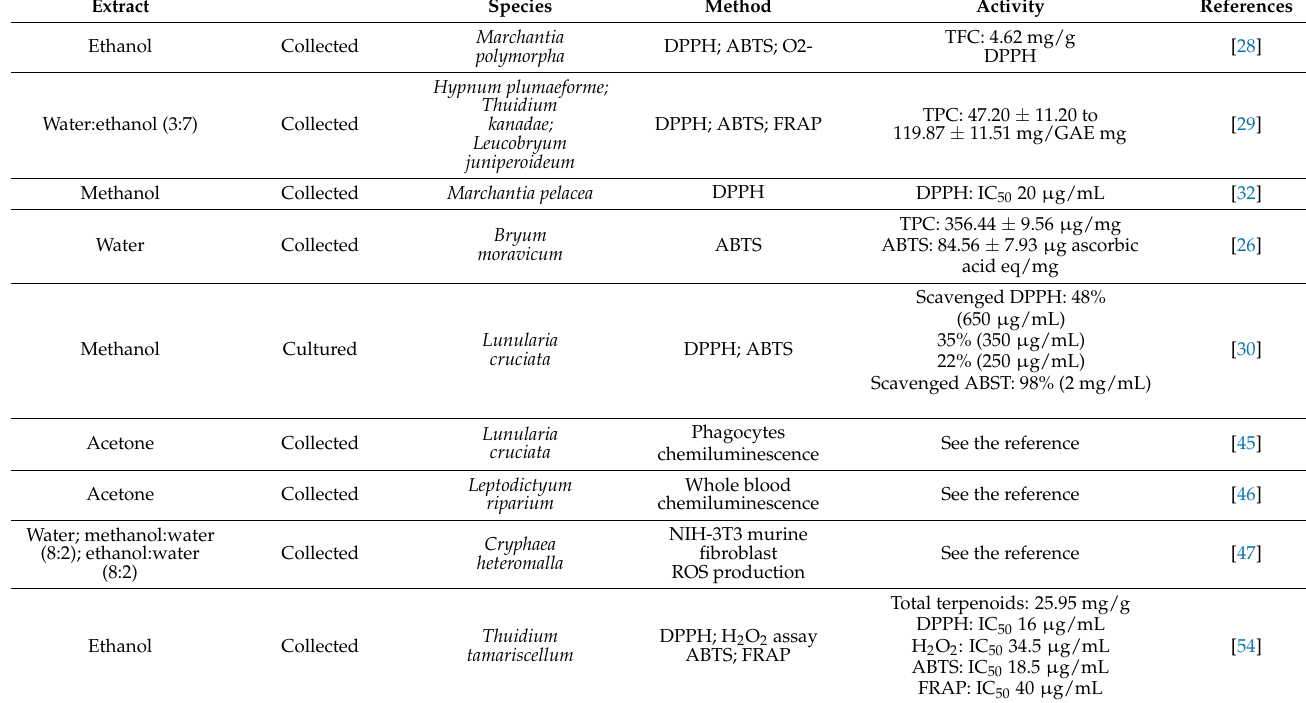
Table 1. List of extracts tested for in vitro antioxidant